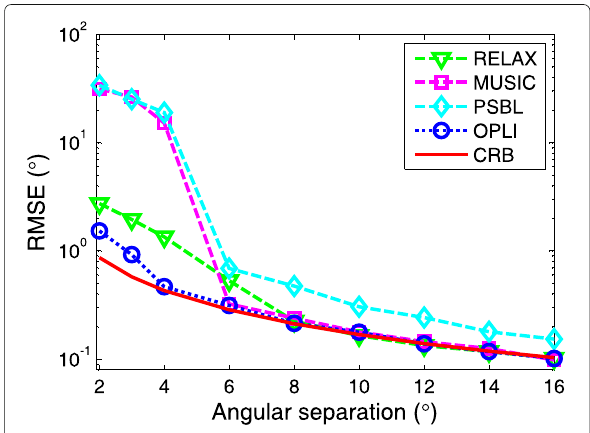
Fig. 6 RMSE versus angular separation Fig. 7 AveRMSE versus input SNR